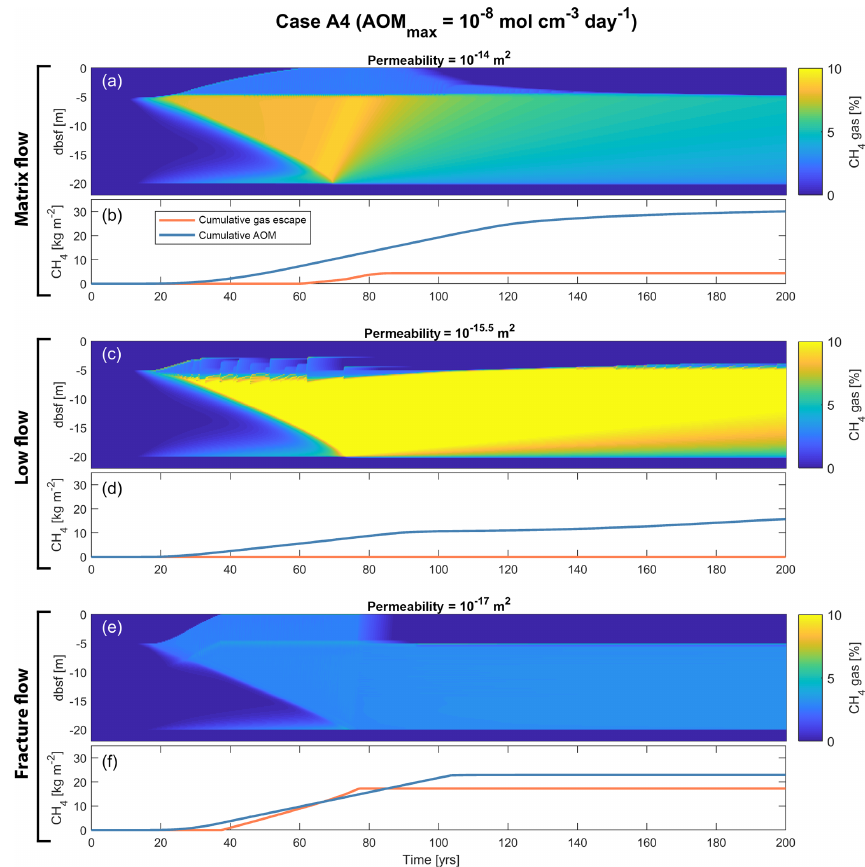
Figure 7. Example of simulation outputs from Case A4, highlighting the different dynamics of the three gas flow regimes within the sed- iments. Shown are sediment CH 4 gas saturation (percentage of pore space) with time and depth below the seafloor, and cumulative CH 4 gas escape and cumulative AOM with time, for three different permeabilities, representing higher-permeability matrix flow (a, b) , mid- permeability low flow (c, d) and lower-permeability fracture flow (e, f) . Note that the hydrate deposit is initially situated between 5 and 20mb.s.f. and that gas is forming at the upper and lower edges of the deposit, which is gradually thinning and is completely dissociated after around 75 years into the